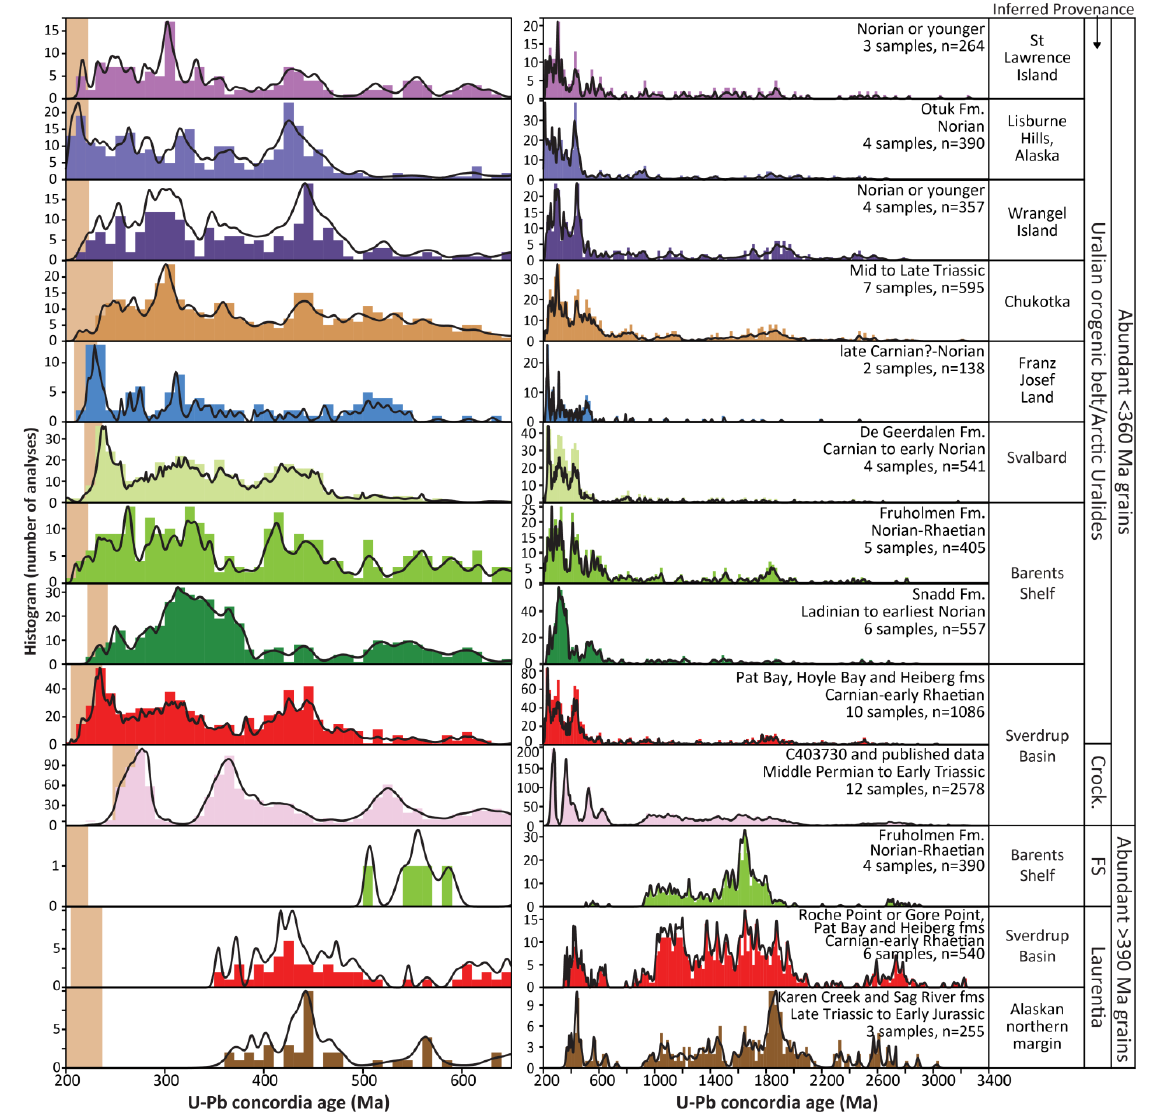
Figure 15. Combined probability density plots and histograms showing detrital zircon U–Pb age data from Middle Permian to Late Triassic strata of the Sverdrup Basin as well as Late Triassic strata from the wider Arctic region. Published data are reprocessed and drawn from the following sources: Sverdrup Basin—Alonso-Torres et al. [15], Anfinson et al. [32], Hadlari et al. [30], Midwinter et al. [33] and Omma et al. [34]; Svalbard—P ó zer Bue and Andresen [153] and Klausen et al. [154]; Barents